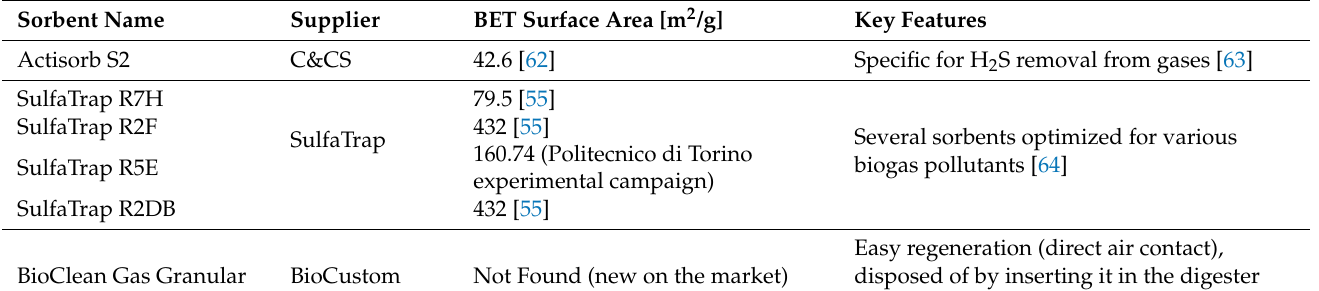
Table 4. Metal Oxide sorbent